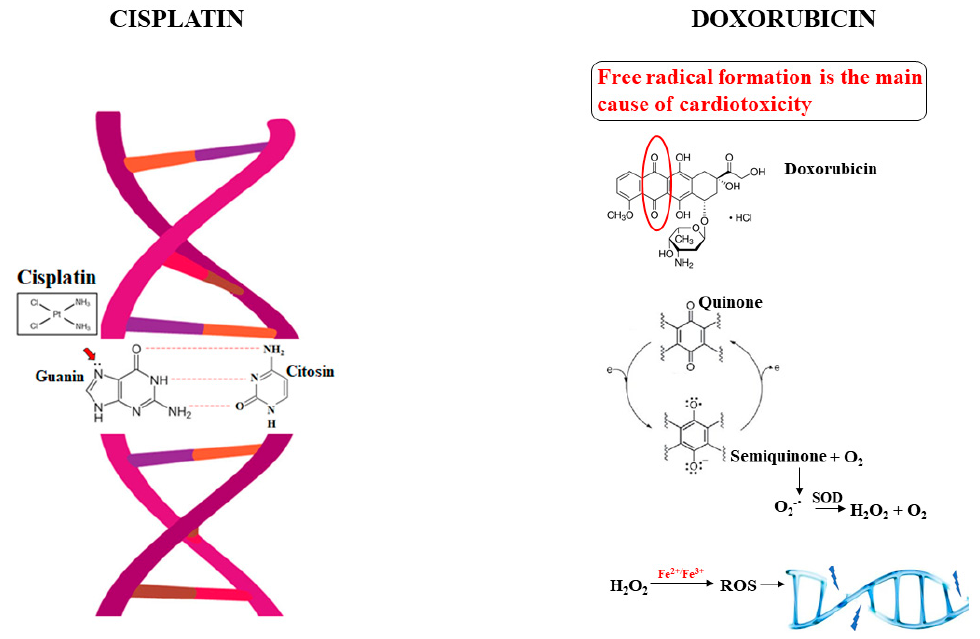
Figure 2. Mechanism of action of Cisplatin and Doxorubicin.